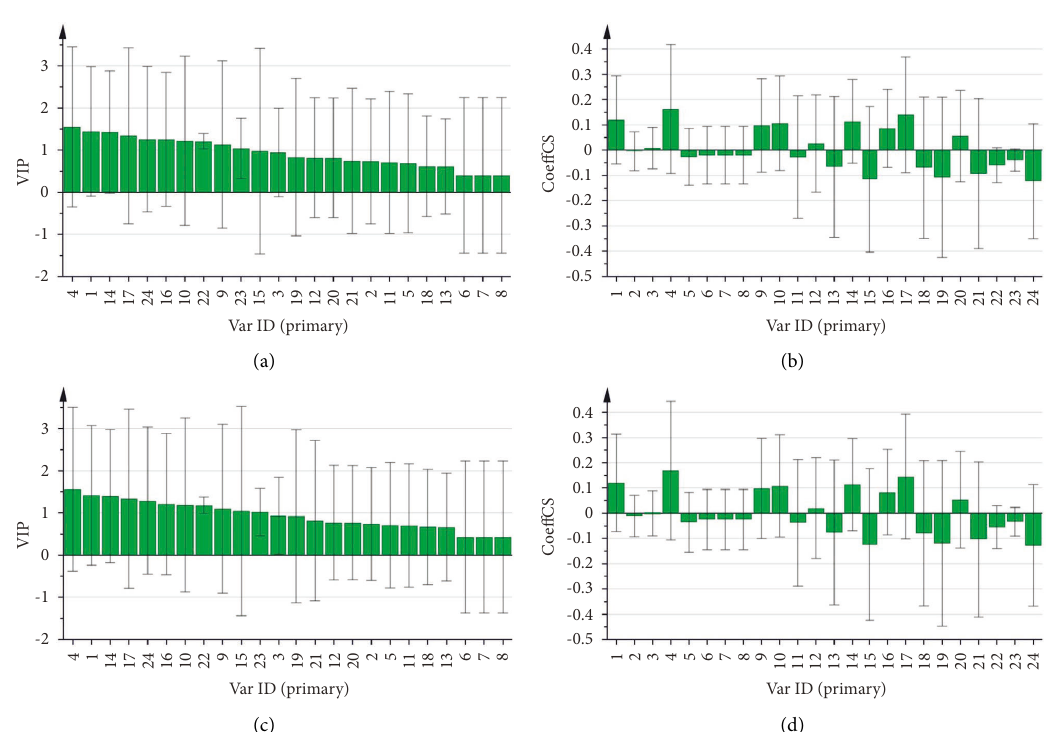
Figure 4: PLSR analysis. (a) VIP scores predicted the TG reduction rates of 24 chromatographic peaks. (b) The coefficient of correlation of 24 chromatographic peaks with the TG reduction rates. (c) VIP scores predicted the MDA reduction rates of 24 chromatographic peaks. (d) The coefficient of correlation of 24 chromatographic peaks with the MDA reduction